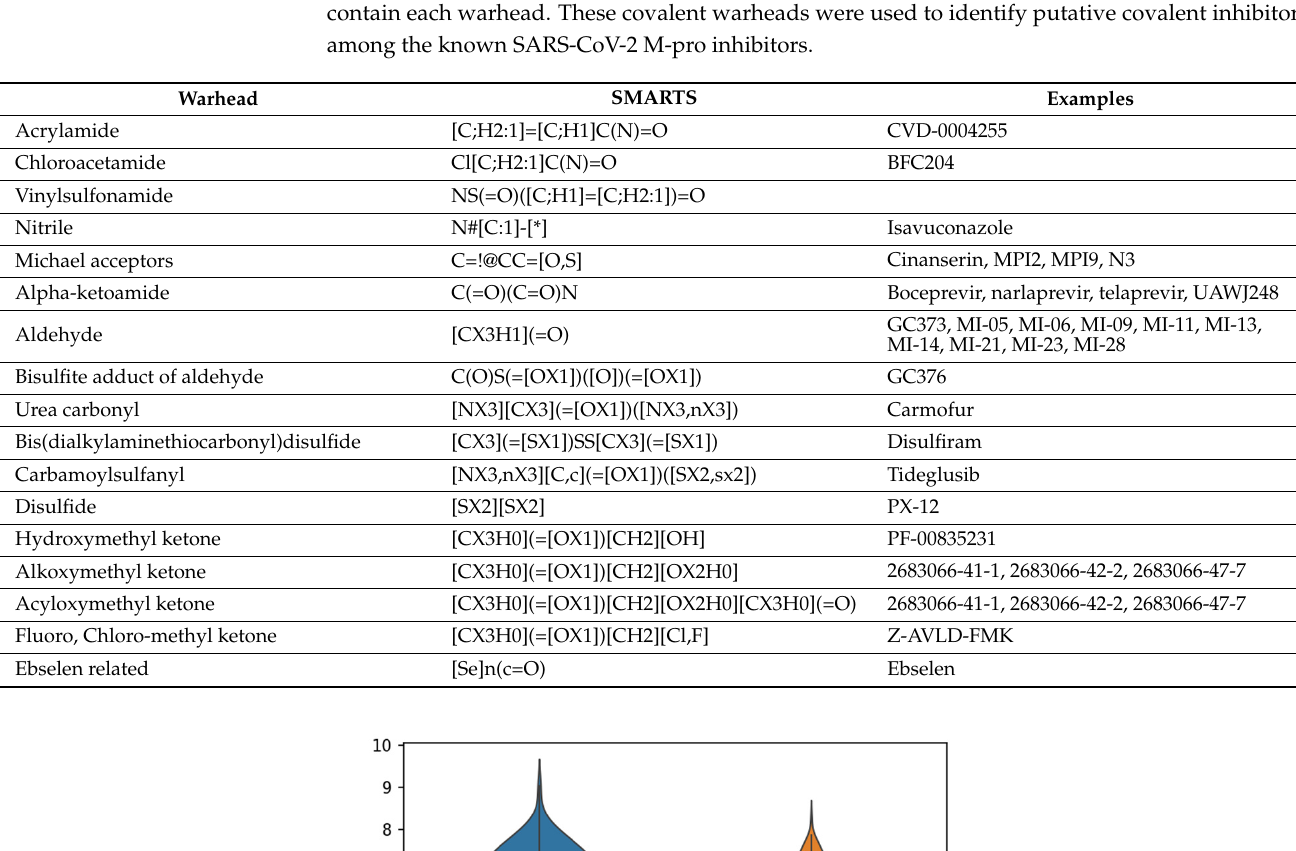
Table 2. Covalent warheads that can be used to identify putative covalent inhibitors. It shows the SMARTS that can be used to identify each warhead and some examples of SARS-CoV-2 inhibitors that contain each warhead. These covalent warheads were used to identify putative covalent inhibitors among the known SARS-CoV-2 M-pro inhibitors.